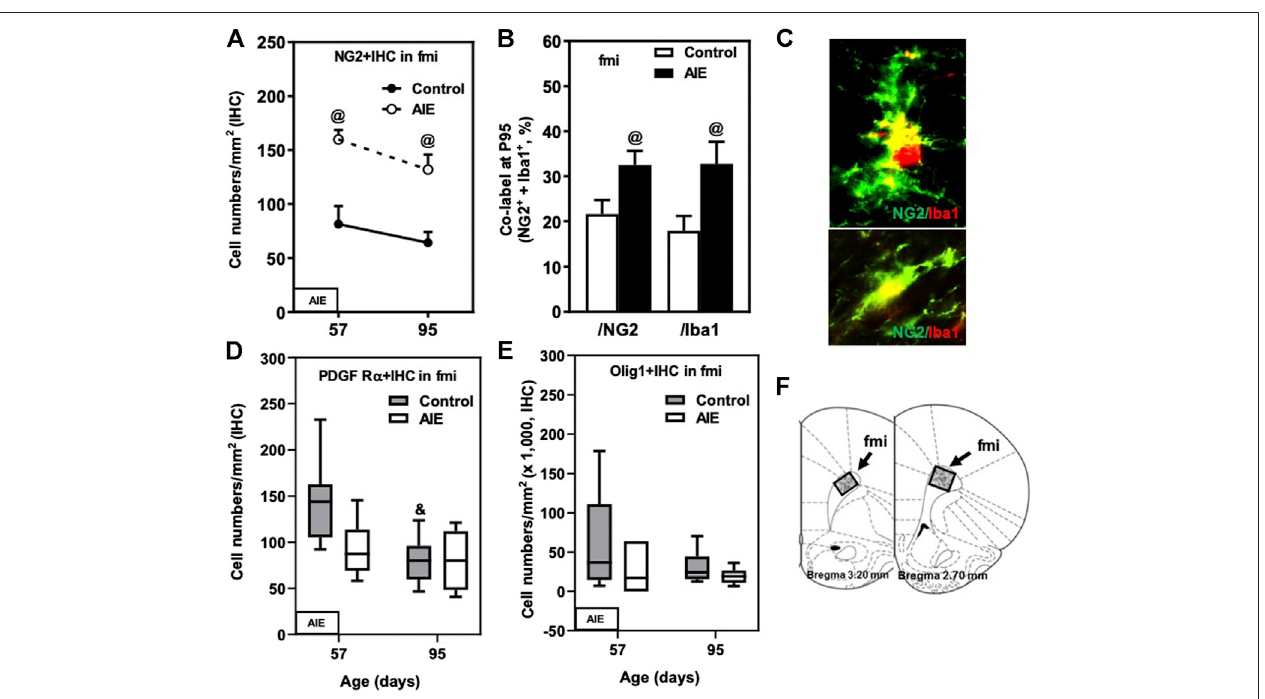
FIGURE2| EffectsofageandAIEonOLmarkersinfrontalcorticalwhitematter,theforcepsminorofthecorpuscallosum(fmi). (A) NG2+IHCexpressionintheAIE groupwashigheratP57(97%)andP95(106%)comparedwithcontrols. (B) AIEexposureresultedinanincreaseofco-localizationofNG2+/Iba1+cellsinNG2+cellsas well as in Iba1+ cells at P95 compared with controls. 50 – 100 NG2+ or Iba1+ positive cells per sample were analyzed for co-localization with Iba1+ or NG2+ cells. The percentage ofco-localization in NG2+ or Iba1+ positive cells was calculated. (C) Photomicrographs ofco-labeled images in the fmi, NG2+ (green) and Iba1+ (red), image 40 × . (D) PDGF R α +IHC expression showed maturational decline in controls from P57 to P95. (E) AIE exposure did not affect Olig1+IHC expression. (F) The fmi region of male rat brain was quanti fi ed by the histological method. The positive cells of oligodendrocyte progenitor and myelin markers of shaded areas were counted. Rat atlas panels were reprinted from Paxinos and Watson (2014). Data were expressed as the numbers of NG2+ (A) , PDGF R α + (D) , and Olig1+IHC (E) positive cells. Each point is mean ± SEM per mm 2 ; n (cid:1) 7 –